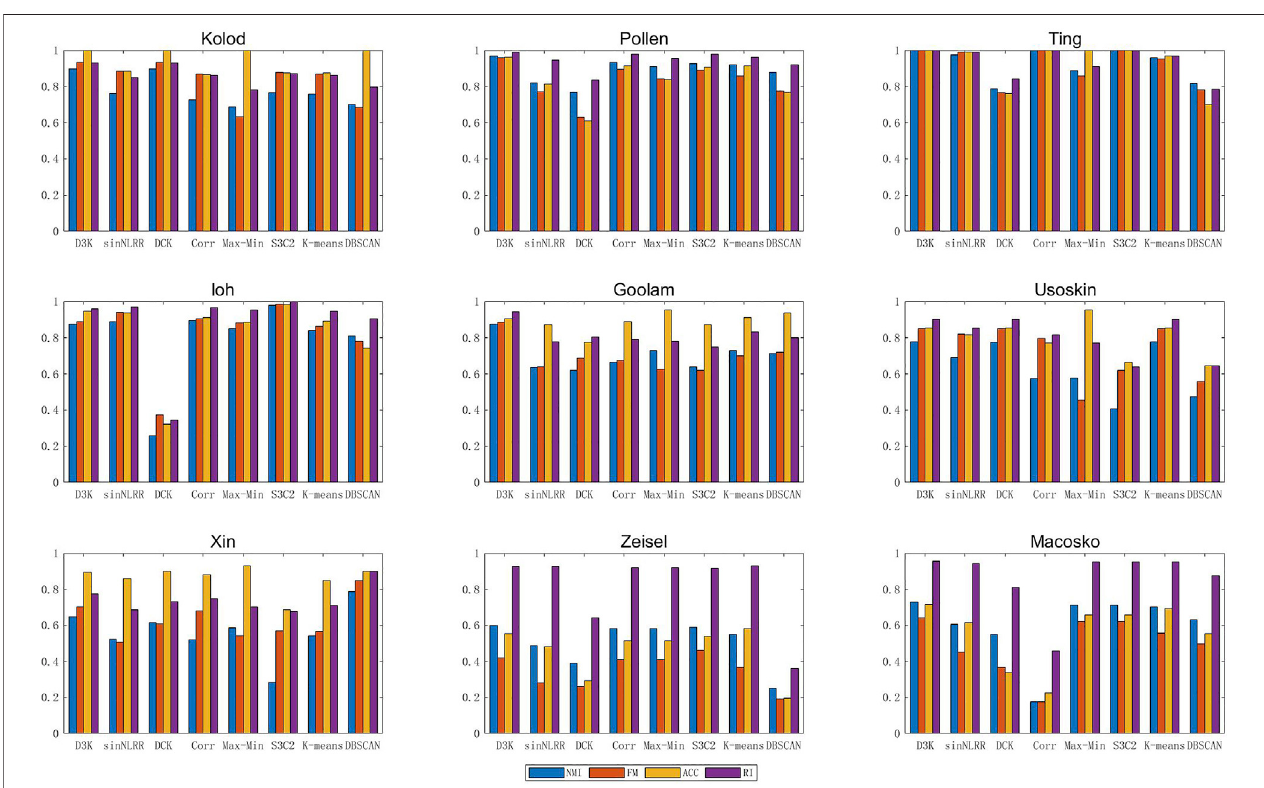
FIGURE 6 | Index of the D3K algorithm in single-cell data aggregation